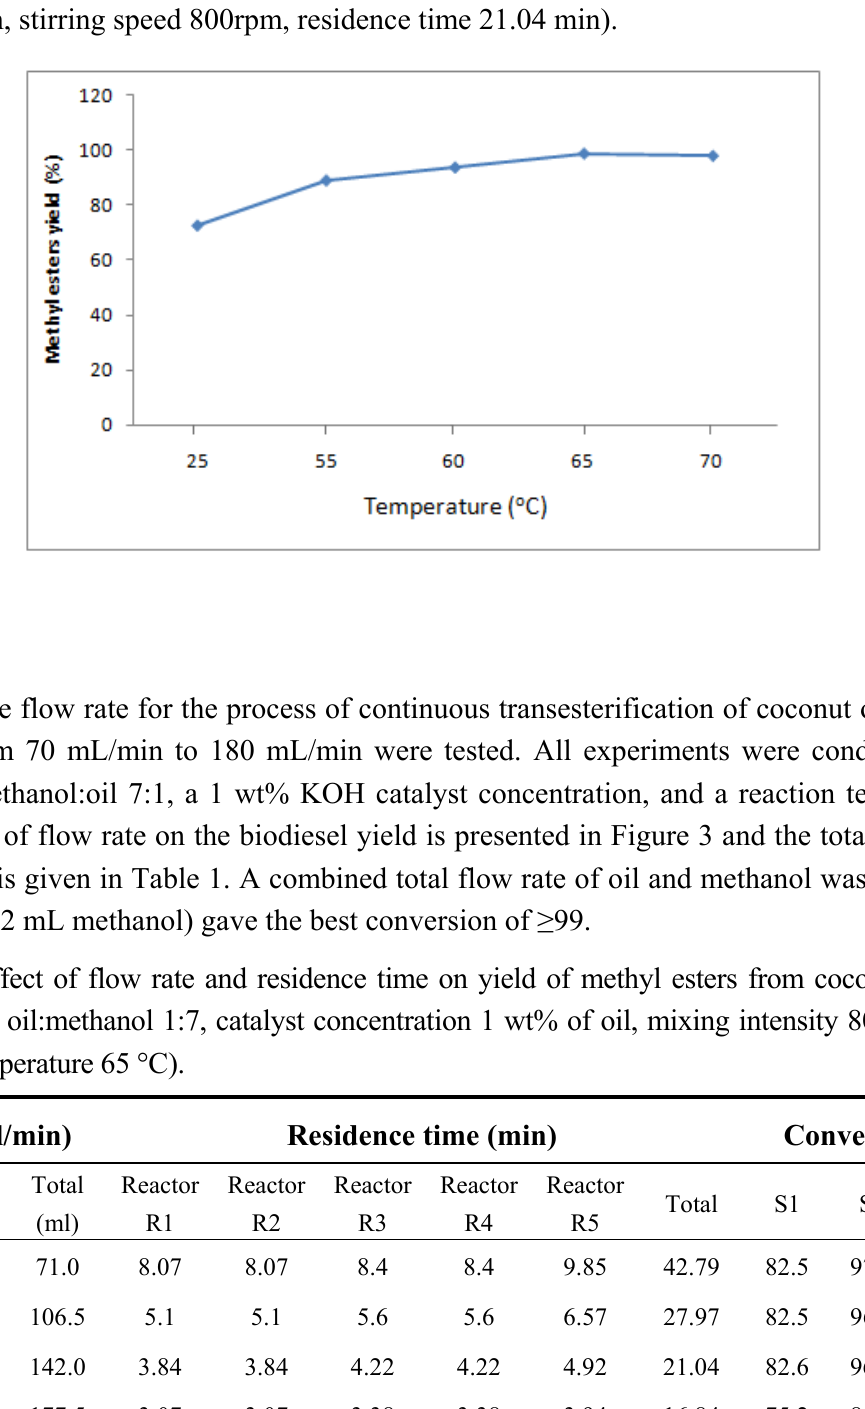
S1 = Separating funnel first, S2 = Separating funnel second, S3 = Separating funnel